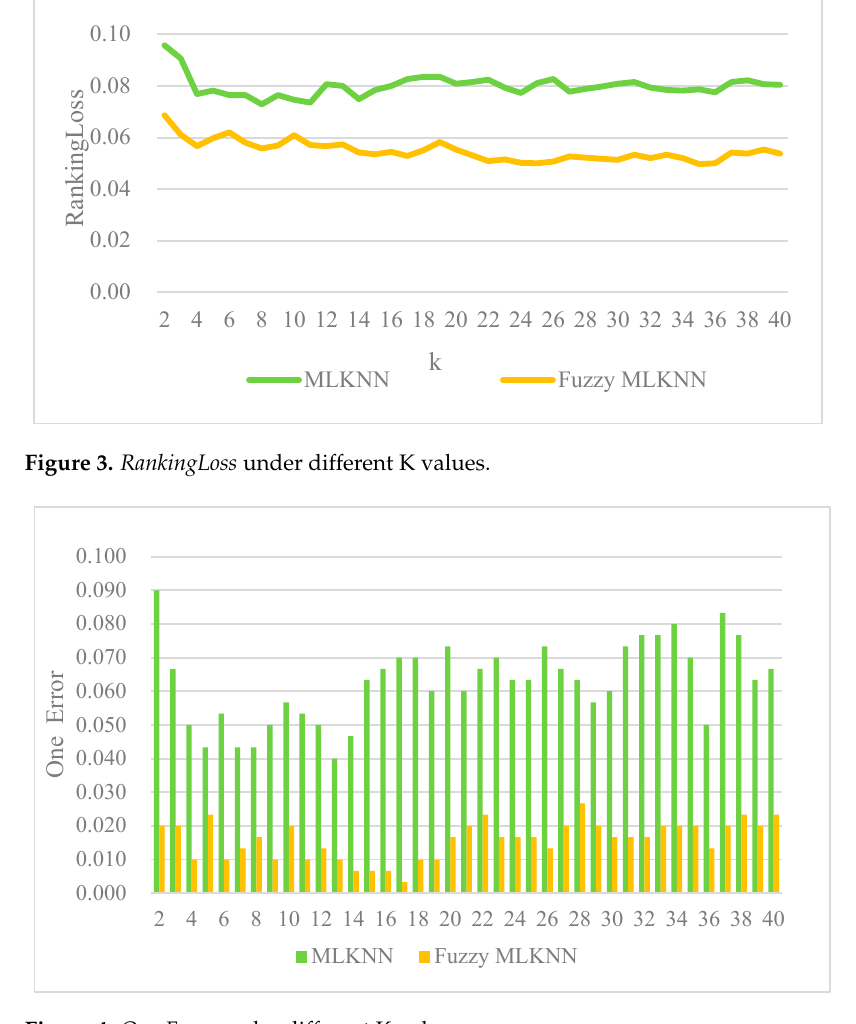
Figure 4. One Error under different K values.